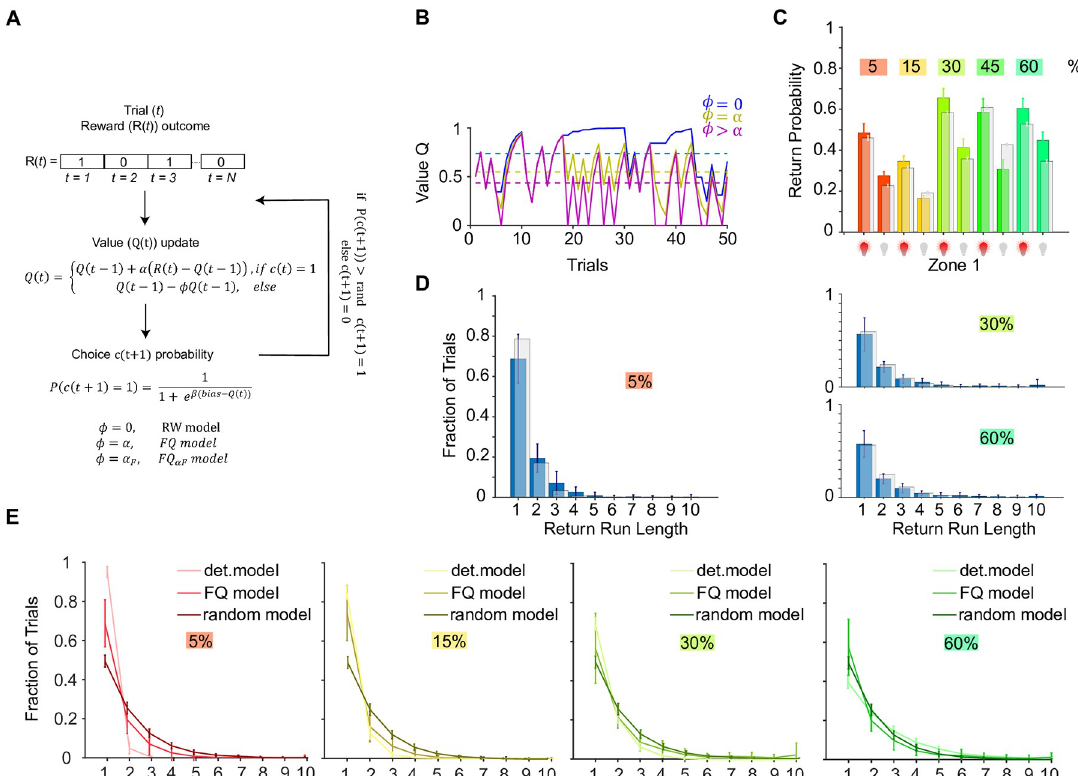
Fig 3. Reinforcement learning model captures reward probability dependent returns. A Schematics of RL algorithm that computes value (Q) and choice (same as return) probability (P(c)) for each trial (t) based on reward (R) history. Q value update on chosen options ( c ( t ) = 1) is controlled by the learning rate α . If choice probability is above a random number (drawn from uniform probability distribution from 0 to 1) the agent returns to the rewarded location (choice equals 1) otherwise it does not. The different RL models differ in how they update the value of unchosen options, controlled by the parameter ϕ , also illustrated in B . B Examples of value evolution over trials for each choice of ϕ . RW model: blue, FQ model: yellow, FQ model: magenta. Dashed lines show average value for a F each model. C Generative test of the FQ model. Return probability separated by stimulated (red light bulb) and unstimulated (grey light bulb) trials to the rewarded zone per probability condition for the data (colored) and the model (grey). Bars: Population mean ± SEM. D Return choice run length histogram for population 5, 30, 60% fly data (blue) and the model (100 simulations, grey). Bars: Mean ± SEM. Run lengths are defined as consecutive returns to the same side. E Return choice run length generated by FQ model compared to deterministic (det) and random models for different reward probability conditions. The deterministic model generates returns with 0.5 probability when experiencing a reward, while the random model generates returns with probability of 0.5 independent of rewards. For each model Mean ± SEM are are